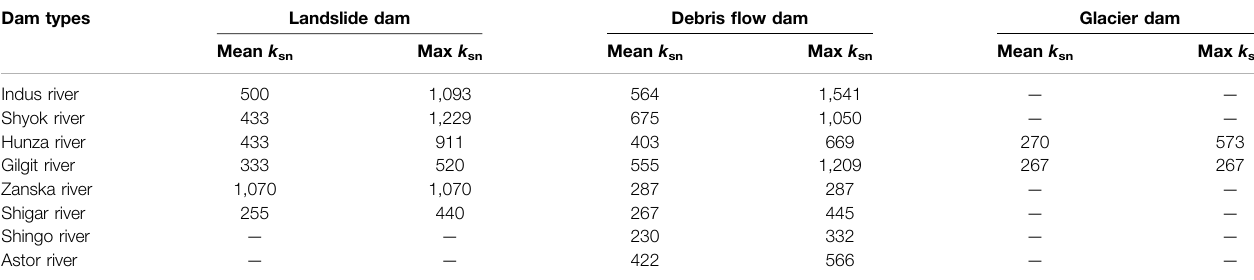
TABLE 5 | Steepness index for each dam type (unit: m 0.9